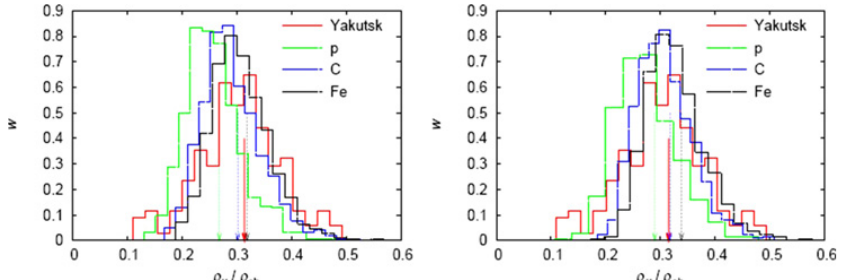
Figure 3. A distribution of the ρ µ / ρ s relation normalized to the track length 500g / cm 2 . On the left – according to models QGSJet II(FLUKA), on the right – according to EPOS(UrQMD).